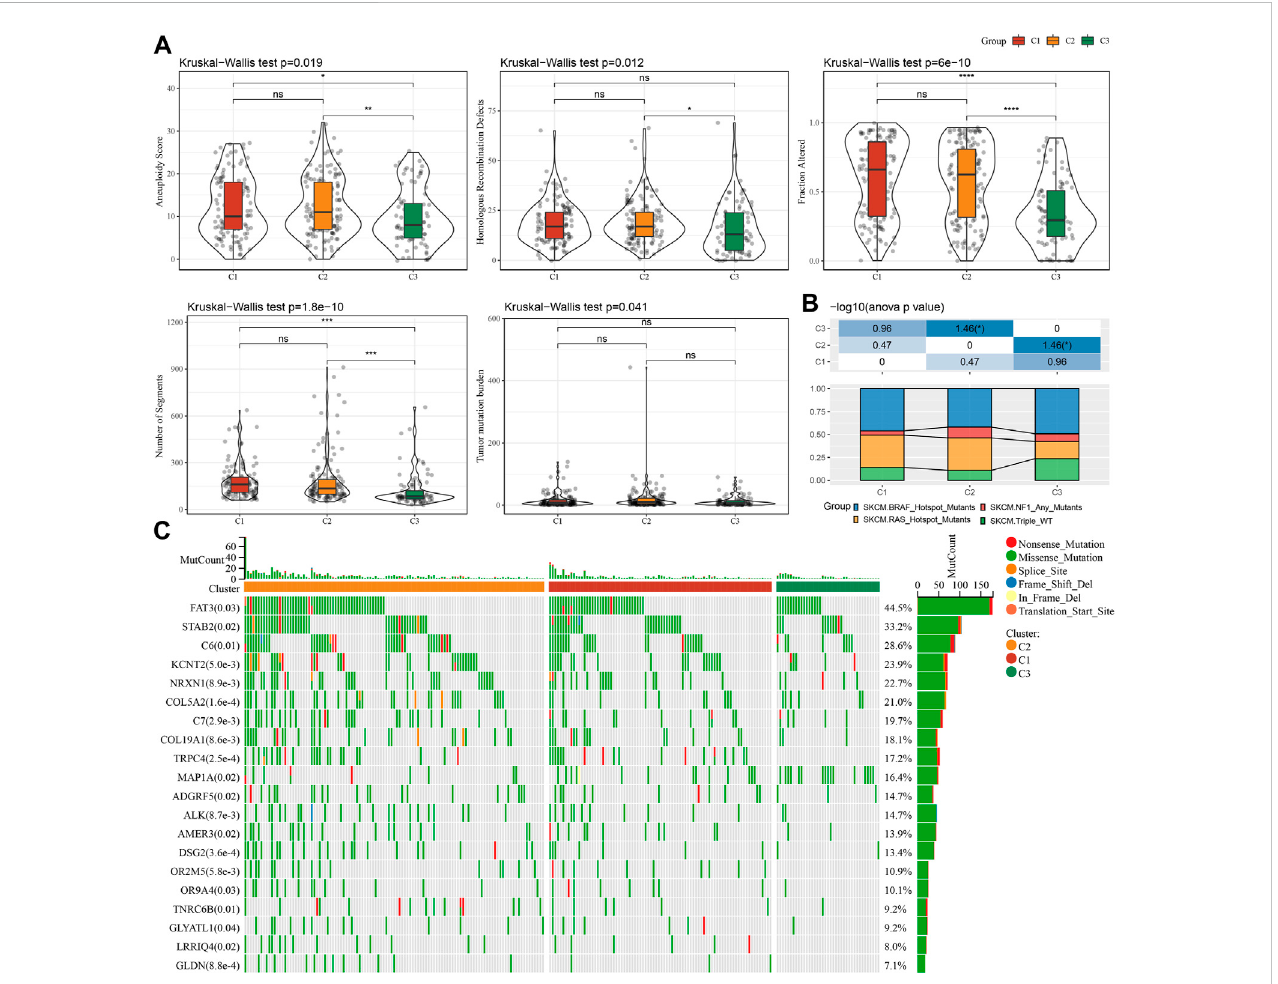
FIGURE 4 Genomic alterations in molecular subtypes of the TCGA cohort. (A) Comparison of Homologous Recombination Defects, Aneuploidy Score, Fraction Altered, Number of Segments, and Tumor mutation burden in the molecular subtypes of the TCGA cohort. (B) Comparison of the three molecular subtypes with other molecular subtypes. (C) Somatic mutations in three molecular subtypes (chi-square